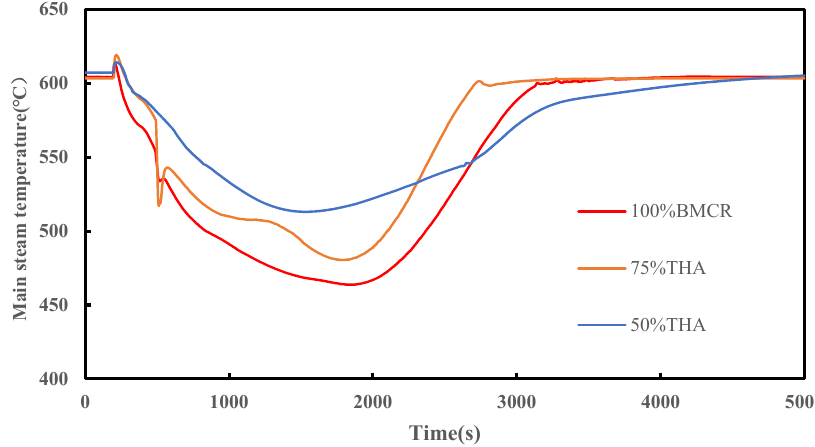
Figure 5. Response of main steam temperature during MFT at different conditions.